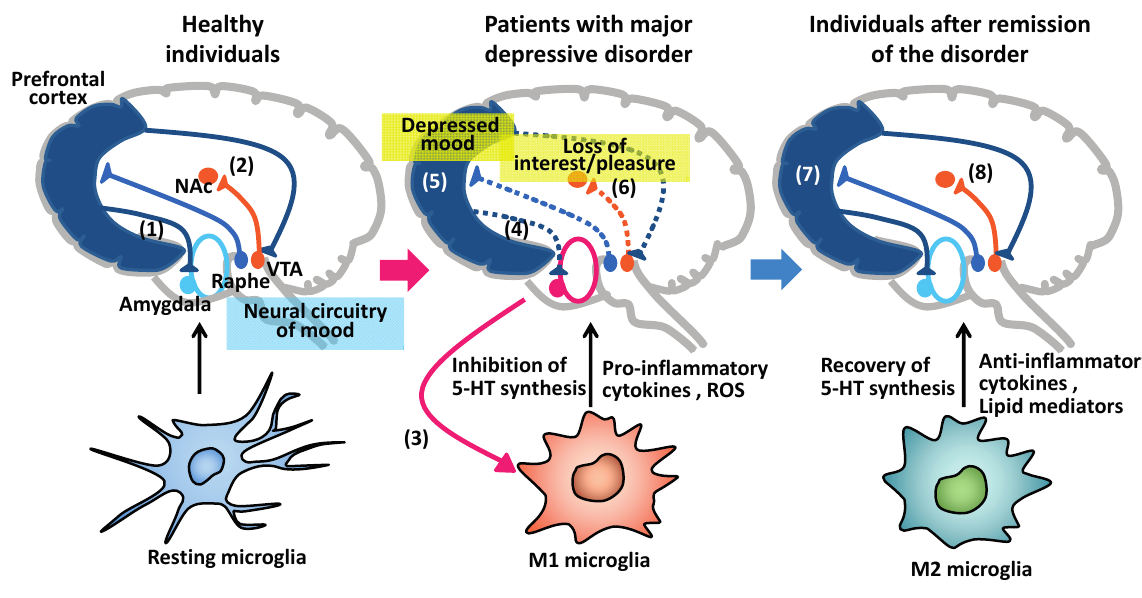
Figure 3. Possible roles of M1/M2 microglia in neural network functions, activities of monoamine neurons, and symptoms in major depressive disorder. In healthy individuals, prefrontal cortex regulates neural circuitry of mood including amygdala and dopamine neurons projecting from VTA (ventral tegmental area) to NAc (nucleus accumbens) (1, 2). In patients with major depressive disorder, hyperactivation of neural circuitry induces M1 polarization of microglia (3), resulting in dysfunction of nerve fibers between prefrontal cortex and the neural circuitry (4) and hypoactivation of 5-HT neurons projecting from raphe nucleus to prefrontal cortex (5). Dysfunction of prefrontal cortex can reduce activity of dopamine neurons projecting from VTA to NAc (6). Hypoactivation of prefrontal cortex and NAc are associated with depressed mood and loss of interest/pleasure, respectively. M2 microglia restore homeostasis of nerve fibers and 5-HT biosynthesis, recovering dysfunction of prefrontal cortex and NAc (7,